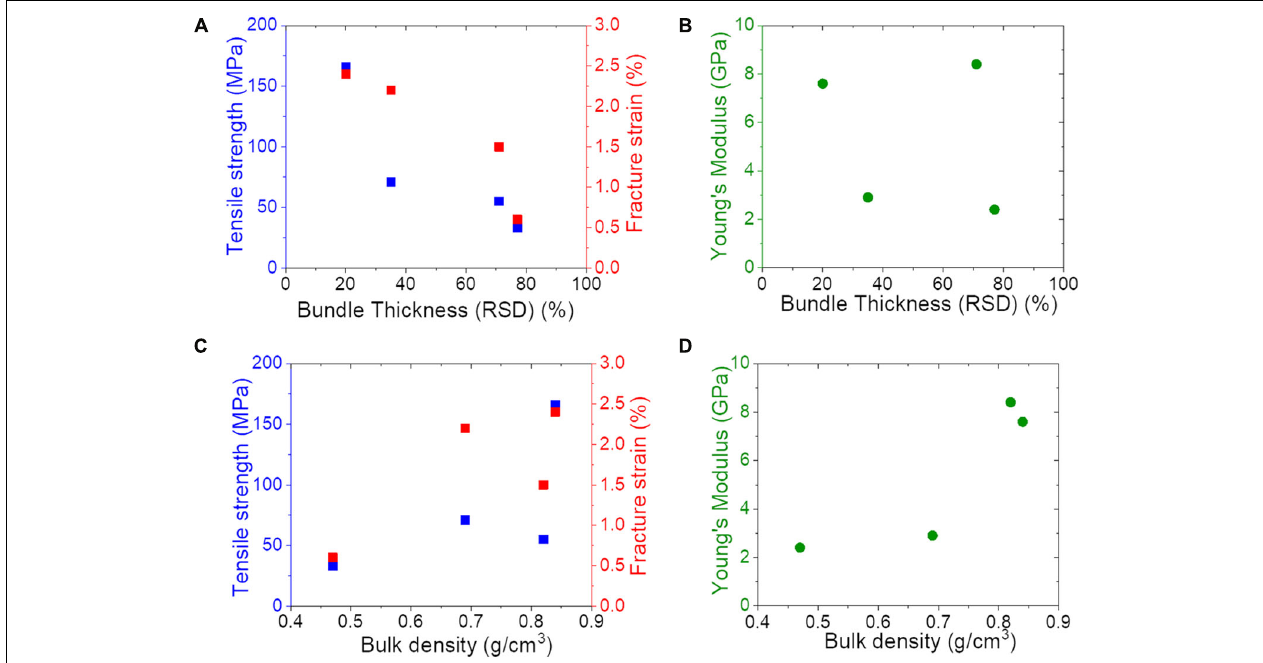
FIGURE 5 | Plots correlating mechanical strength and bundle network structure. (A,C) Tensile strength (blue), fracture strain (red), and (B,D) Young’s modulus (green) versus bundle thickness distribution and bulk density of the CNT films.